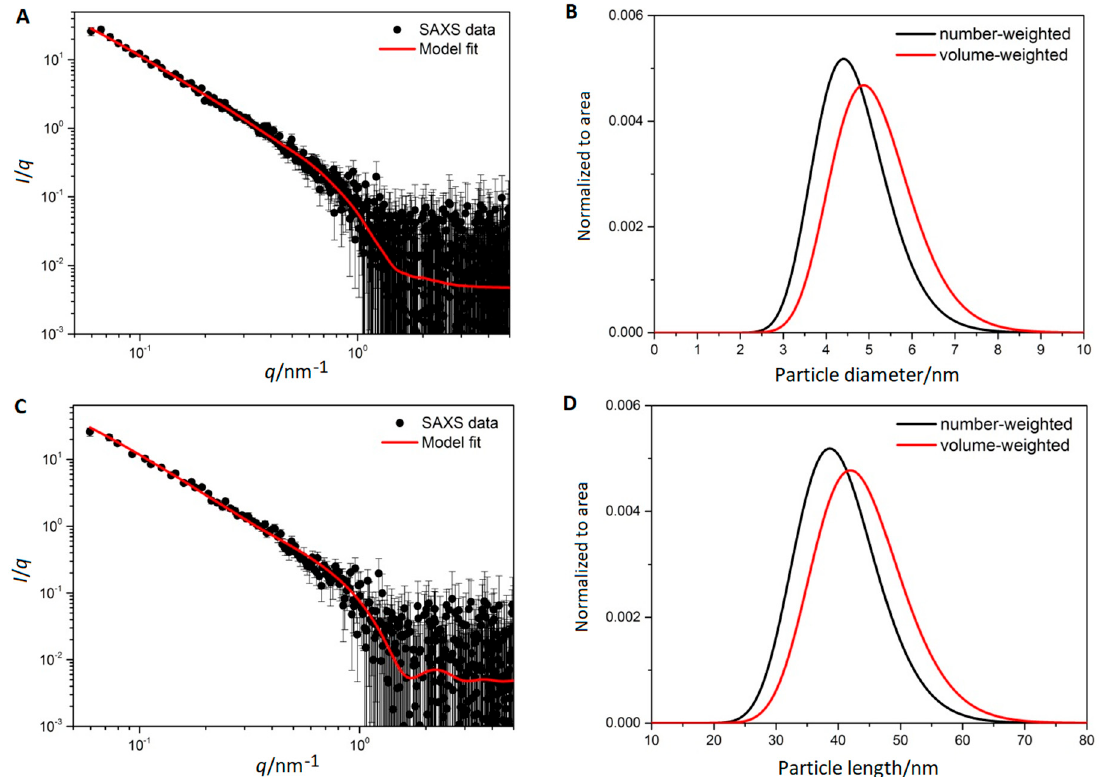
Figure 3. Scattering curve of zinc ferrite nanorods in aqueous dispersion and its fit modelled with cylindrical particles of unique length ( A ) and log-normal distribution of rod diameters ( B ). Below are: fit modelled with cylindrical particles of unique radii ( C ) and log-normal distribution of rod lengths ( D ).